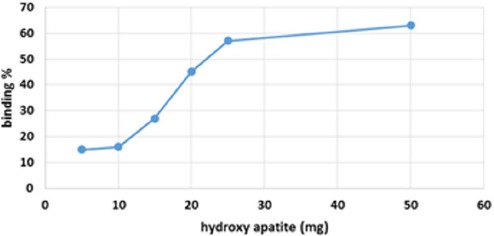
Binding of 68Ga-DOTA-ALN in the presence of 5-50 mg of HA